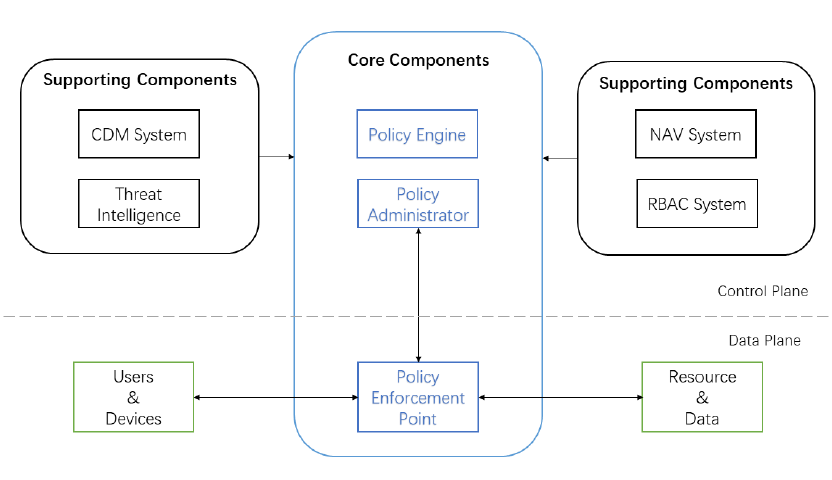
Figure 4. The high-level architecture of the zero-trust model implemented on